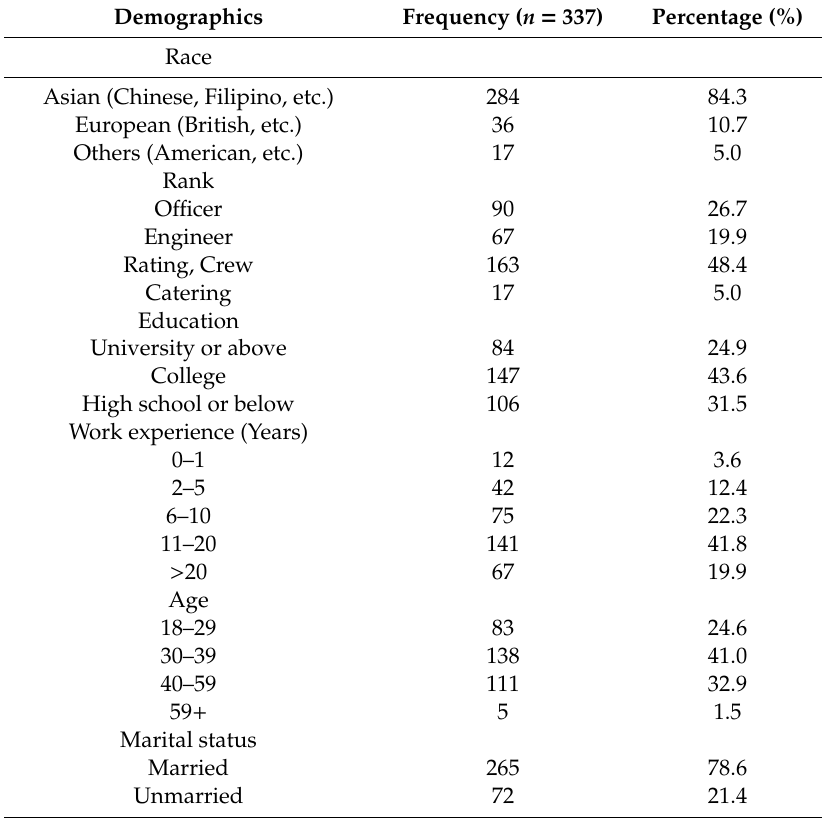
Table 1. Demographics of participants.